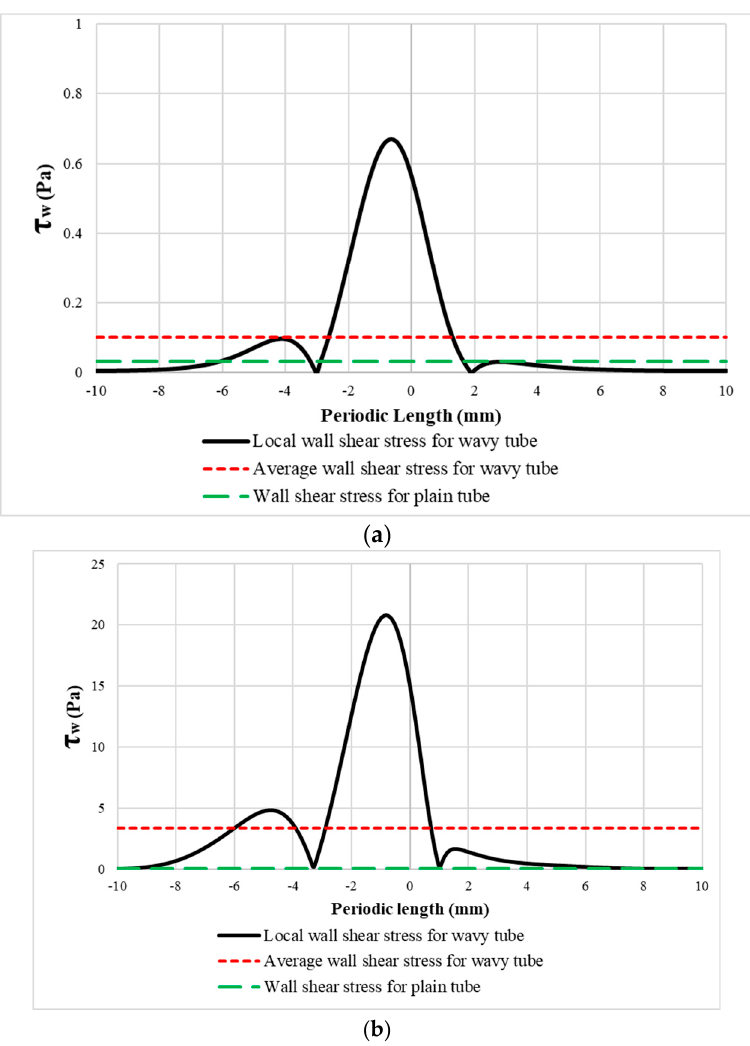
Figure 5. Wall shear stress distribution for wavy-walled tube ( a ) F w = 0 . 58 and Re D = 100 (Laminar) and ( b ) F w = 0.58 and Re D = 1000 (Turbulent).